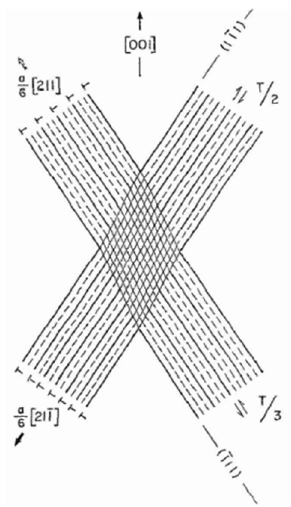
Figure 7. Olson and Cohen’s refinement of Bogers and Burgers’ model. The α martensite is formed at the intersection of the two planar faults T/2 and T/3. Reprinted from [56] with permission from Elsevier.